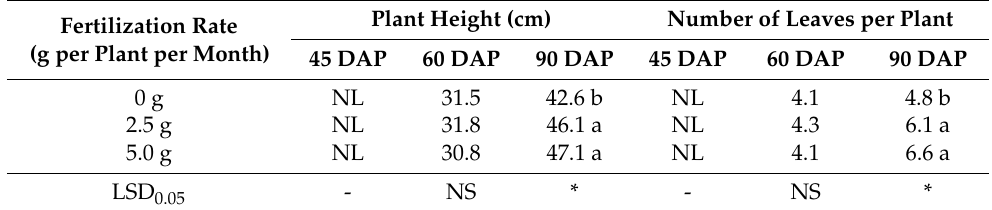
Table 1. Effect of fertilization rates on growth and Hippeastrum ‘Red Lion’ at different growing stages. Fertilization